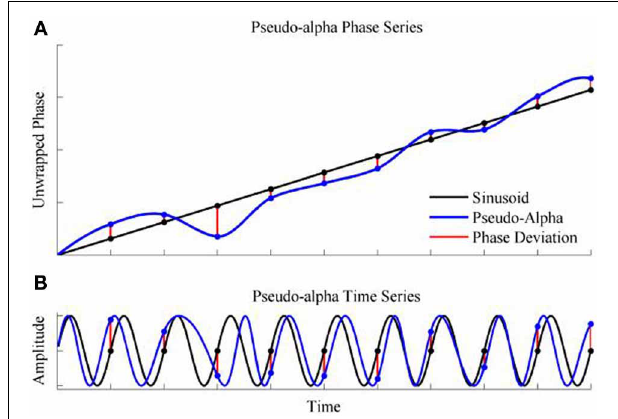
FIGURE 4 | Simulation of the pseudo-alpha rhythm. (A) Shows the unwrapped phase of a regular 10Hz sinusoid (Black line) with random phase deviations generated from the von Mises distribution (Red lines) and added to the sinusoid at 100ms interval. The phase series for the pseudo-alpha rhythm is formed by a smooth line (Blue line) that connects the points of the sinusoid + phase deviation. (B) Shows the times series generated by taking the sine of the phase series in (A)